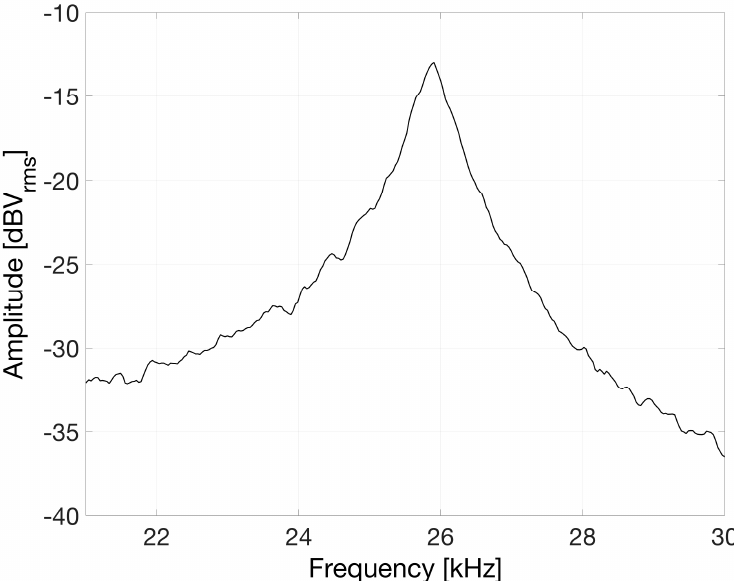
Figure 5. Frequency response of the fundamental out-of-plane vibration mode of the micro-membrane obtained by driving the piezo-actuator with electrical white noise.